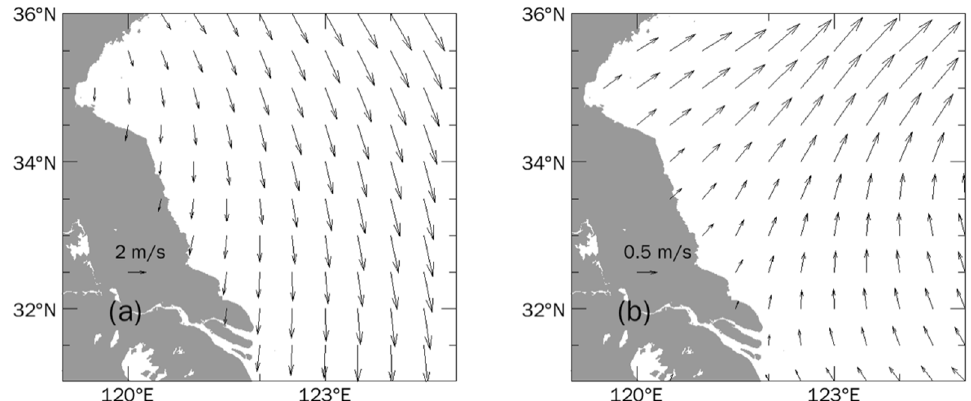
Figure 7. ( a ) Climatological winter wind distribution and ( b ) wind anomaly in the winter of 2020–2021 at 10 m above the southwestern Yellow Sea.